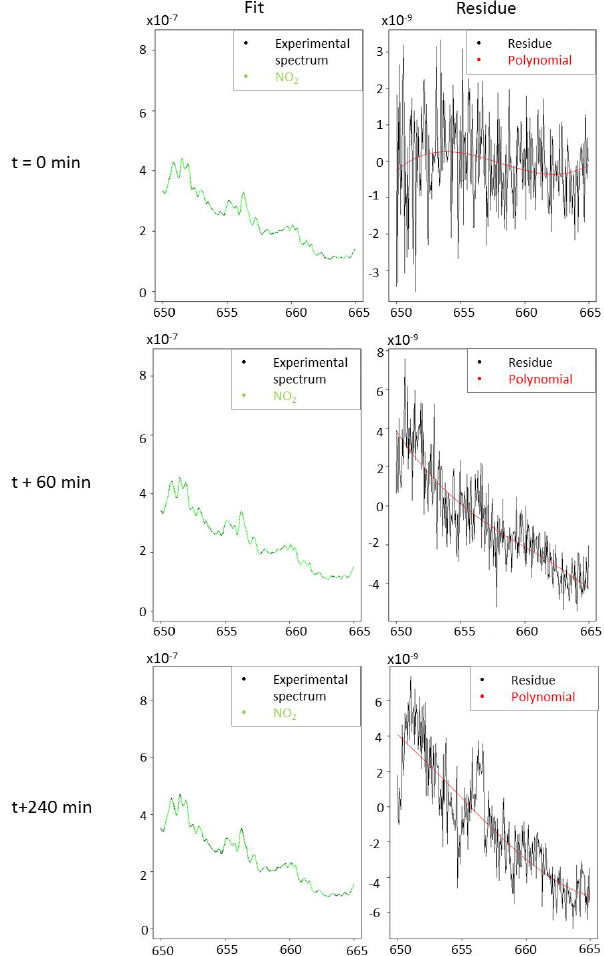
Figure 3. Evolution of fit quality for 1ppm of NO 2 as a function of time since I 0 was